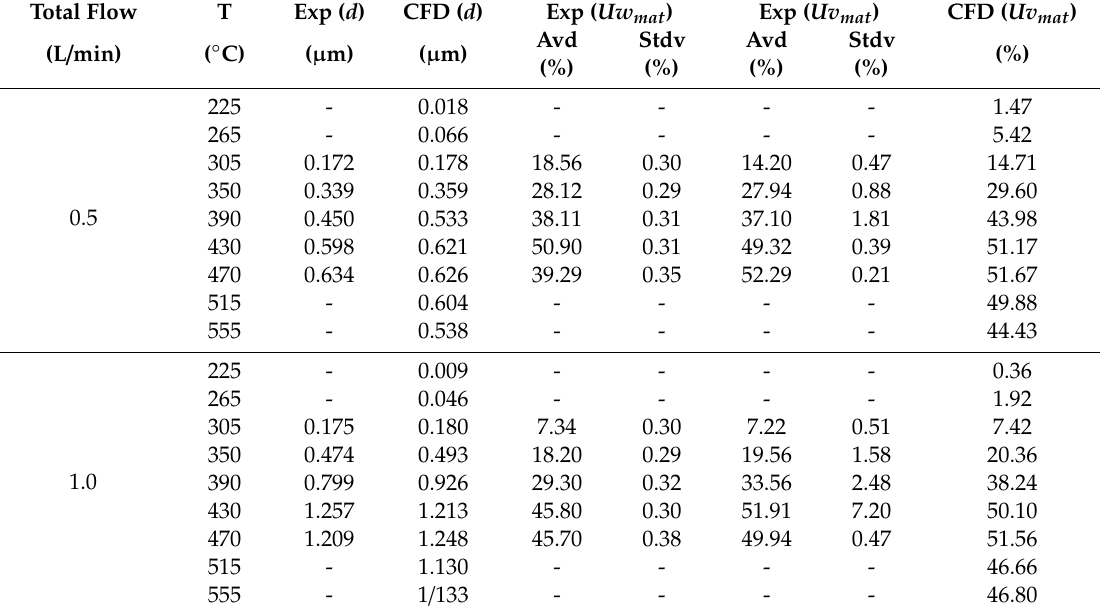
Figure 8. Using the S-1 configuration for the chamberless coating head during the deposition of CdTe, results are displayed as ( a ) an Arrhenius plot of ln( GR ) vs 1/ T used to calculate the activation energy and ( b ) a VI:II precursor ratio vs activation energy. GR: growth rate.